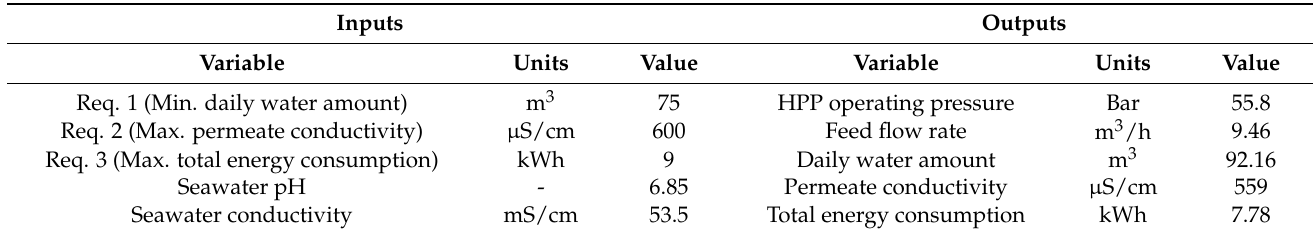
Table 8. Sample of the “Smart System”